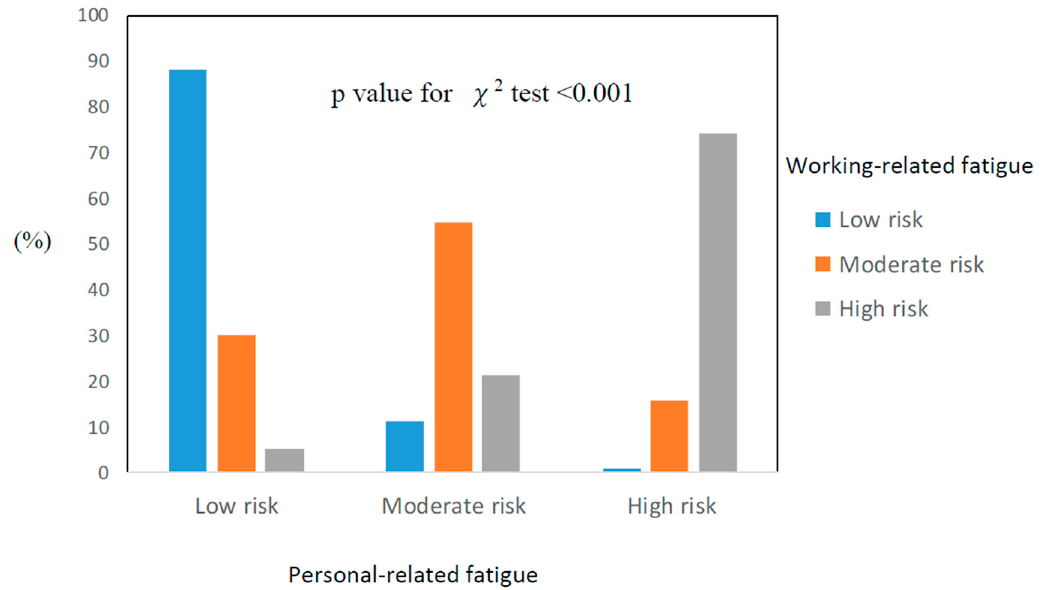
Figure 1. The association between personal-related fatigue and working-related fatigue among the study population ( n = 2132).